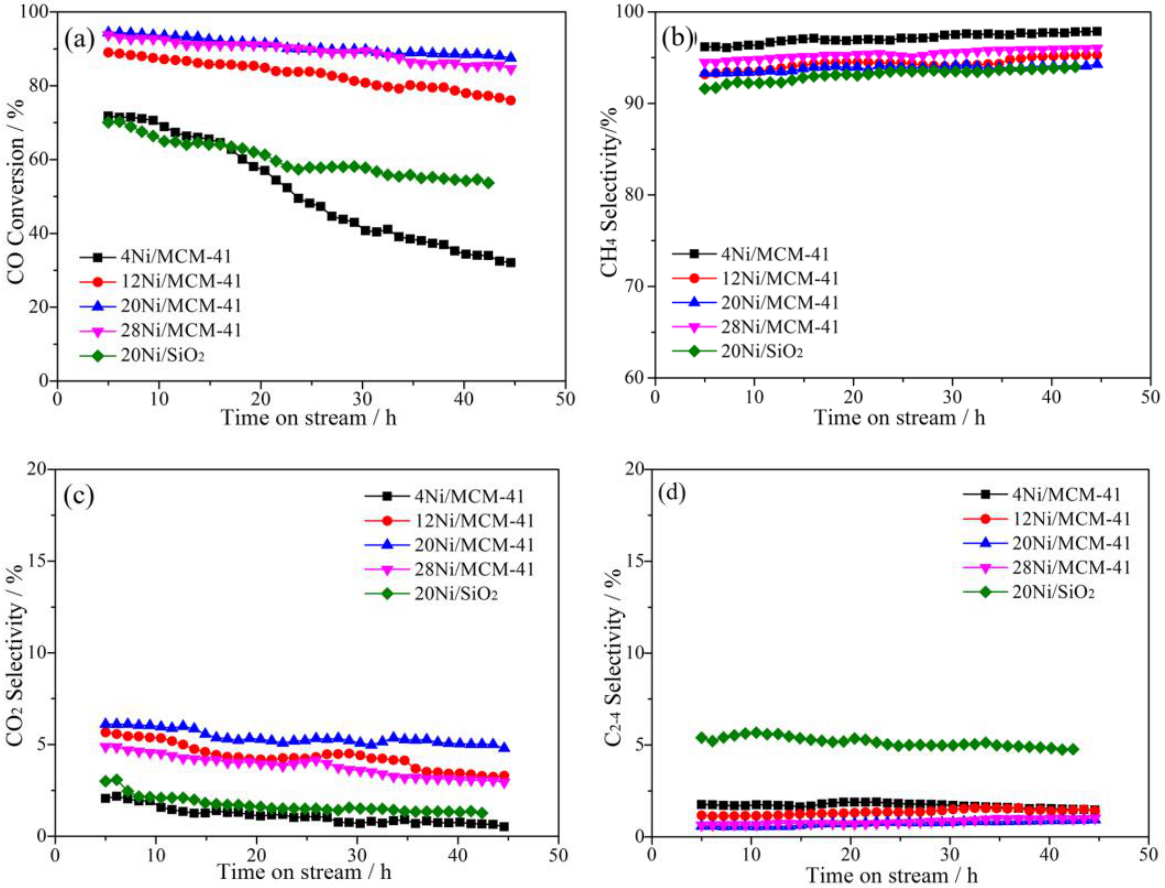
Figure 1. Effect of Ni content on catalytic performance for CO methanation over Ni-based catalysts. ( a ) CO conversion, ( b ) CH 4 selectivity, ( c ) CO 2 selectivity, ( d ) C 2–4 selectivity. Reaction conditions: 300 °C, 1.0 MPa, and 3000 mL/(g·h).